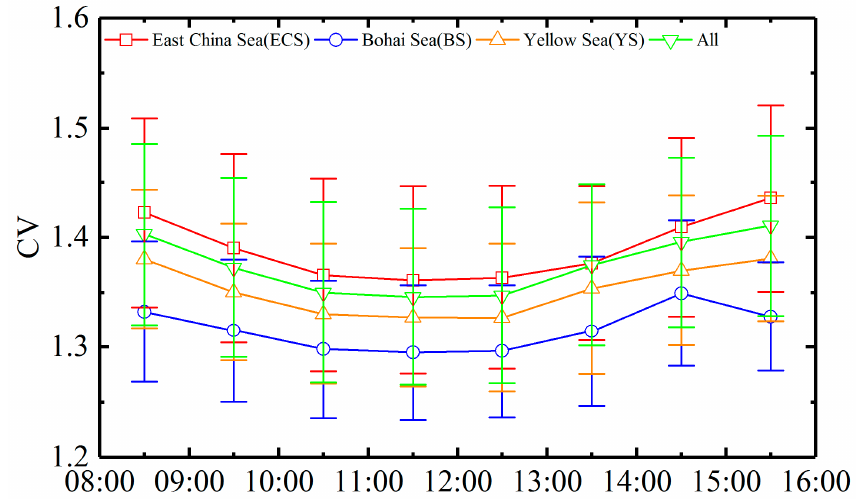
Figure 9. CV trend in hourly TSS levels in Chinese seas from GOCI observations from 2013 to 2017.